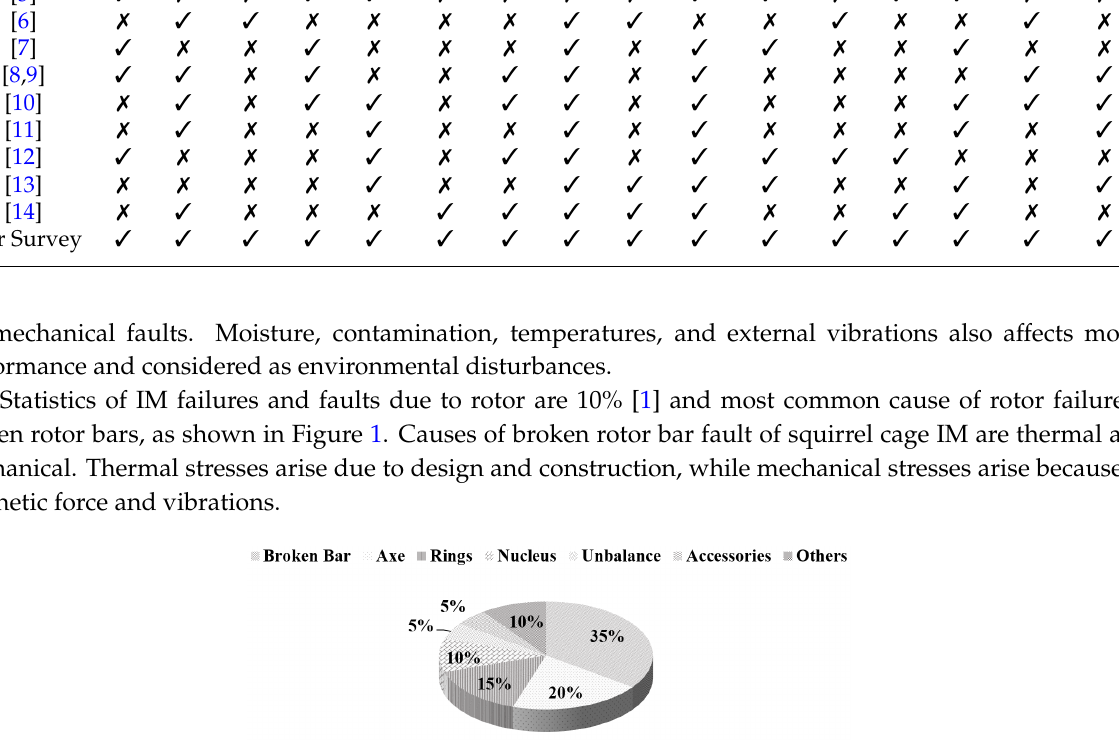
Figure 1. Problems in machine